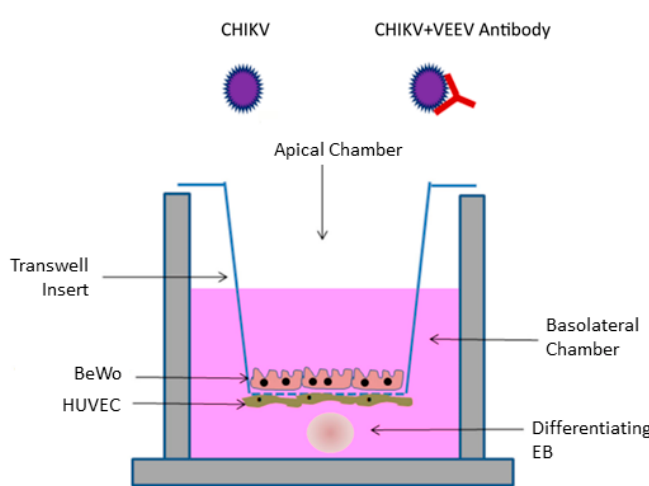
Figure 1. Experimental model of the trans-well co-culture assay modified from Campagnolo et al. (2018) [23]. Co-cultures of BeWo, HUVEC, and embryoid body (EB) were apically infected with either Chikungunya virus (CHIKV) or CHIKV + VEEV (Venezuelan equine encephalitis) antibody.